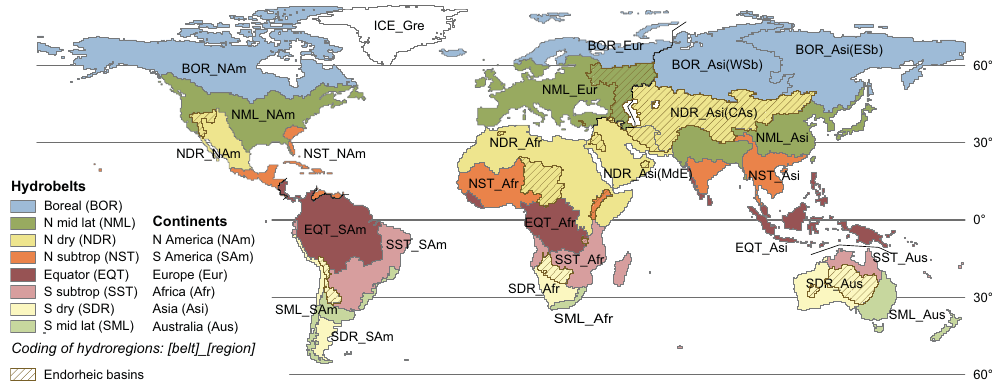
Fig. 2. Limits and coding of global hydrobelts and hydroregions.